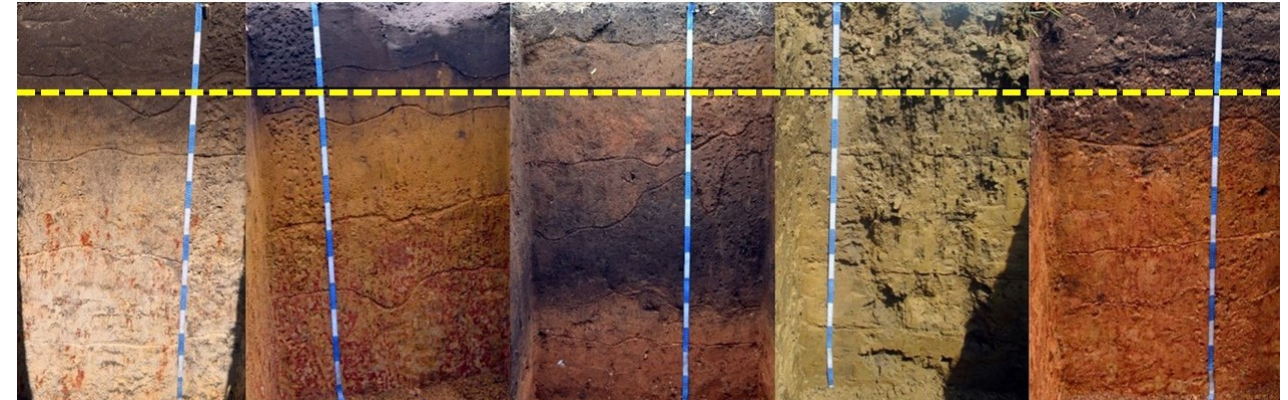
Figure 6. Photographs of five soil profiles of the study area indicating the topsoil (30 cm). The horizontal-yellow line indicates the “arable layer of the soil”; The vertical line with alternating colors every 10 cm is the tape measure.